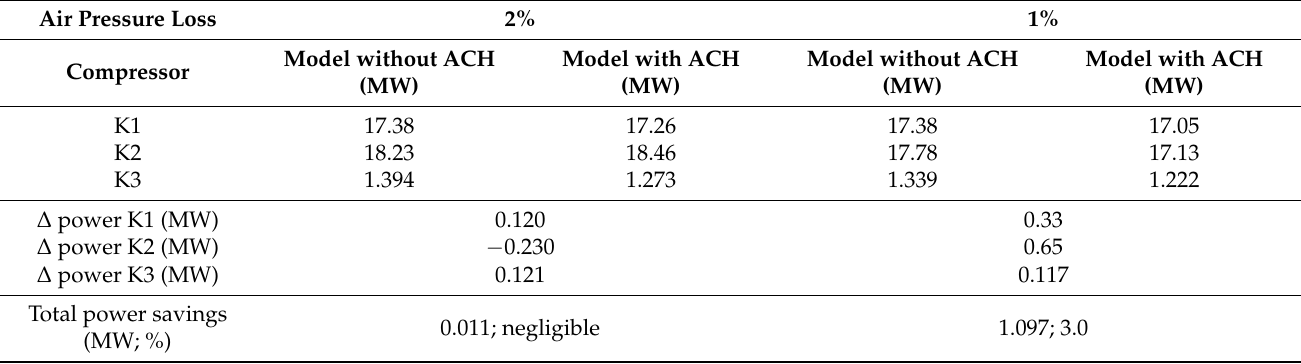
Table 12. Key model parameters sensitivity to air pressure loss in heat exchangers. ∆ :